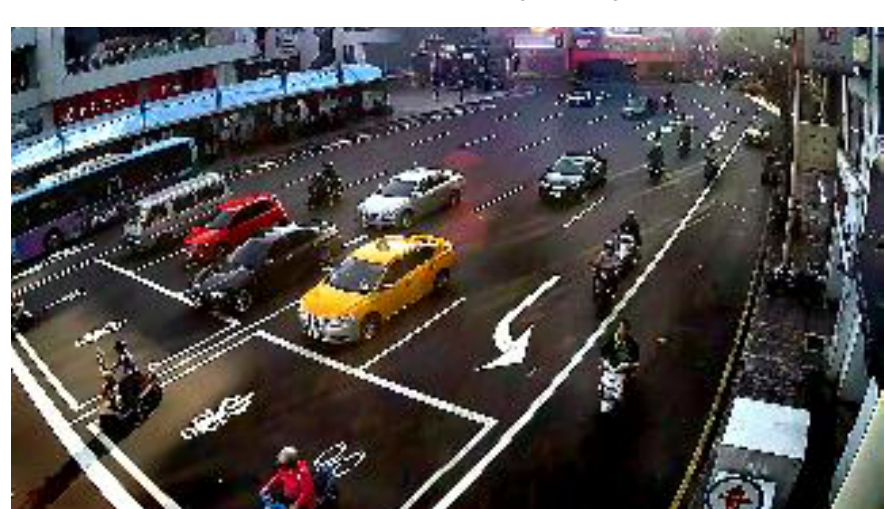
Figure 17. Glare scene: correction result.